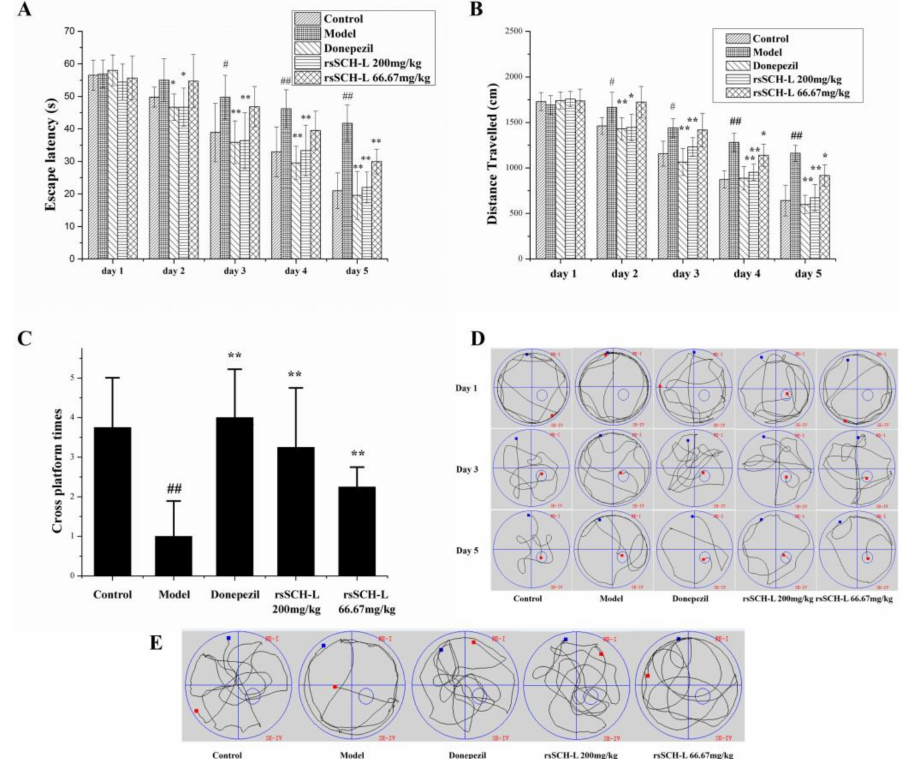
Figure 1. Effects of rsSCH-L on A β 1-42 -induced cognitive impairment in rats. ( n = 10) ( A ) Escape latency, ( B ) Distance travelled, ( C ) Cross platform times, ( D ) Representative search strategy of rats in the trial on the first, third, and fifth days, ( E ) Representative swim paths during the spatial probe test are shown. # p < 0.05, ## p < 0.01 vs control group, * p < 0.05, ** p < 0.01 vs. A β 1-42